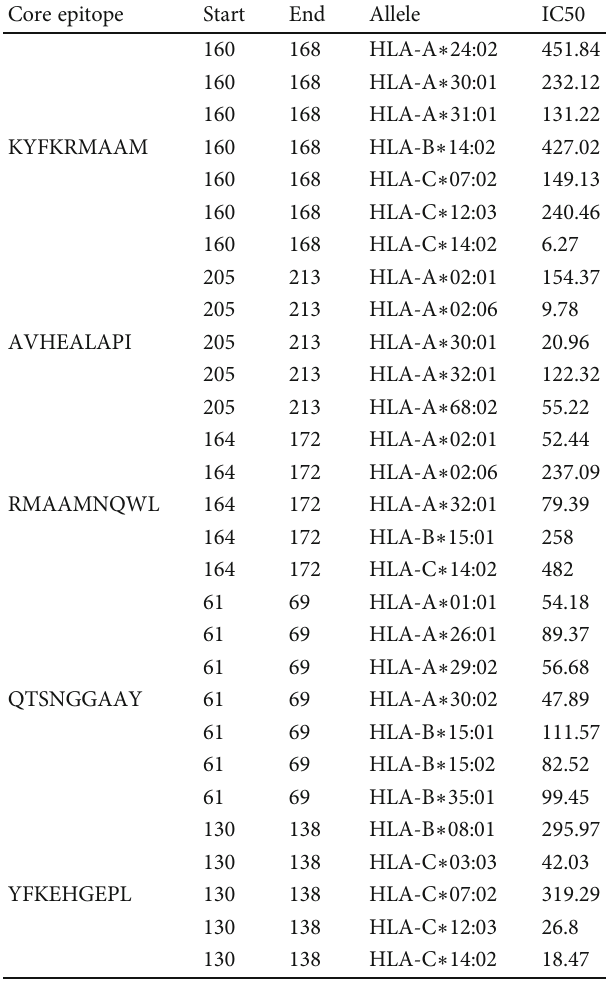
Table 4: Promising T-cell epitopes (class MHC I alleles) with their position and IC50